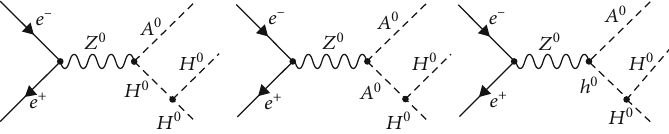
Figure 16: The Feynman diagram for scattering process e − e + ⟶